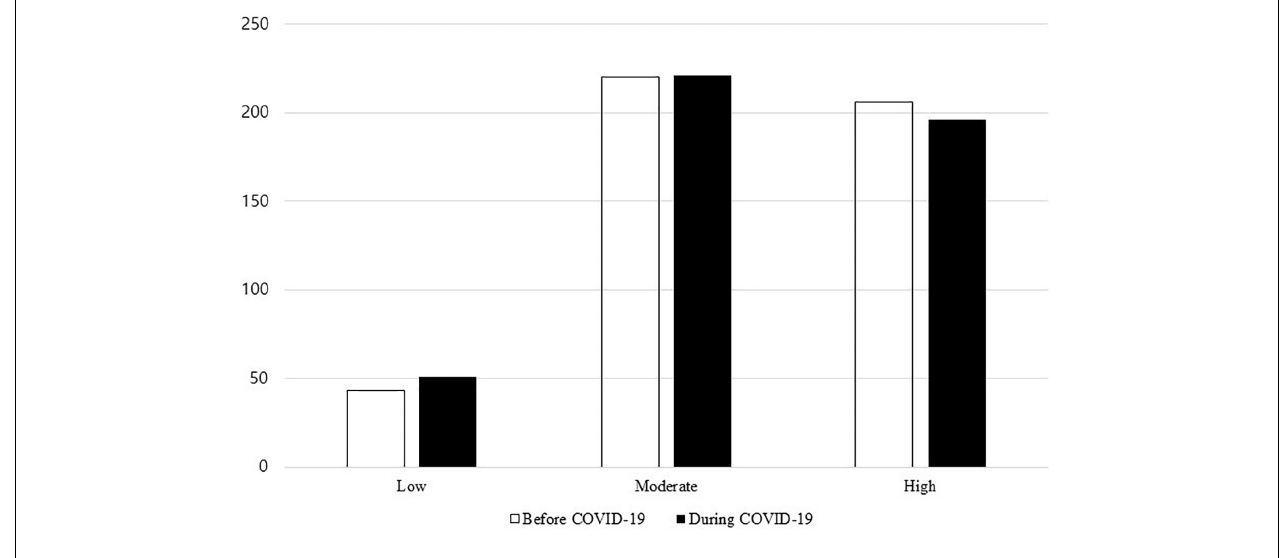
FIGURE 1 | Physical activity classification of males before and during COVID-19.